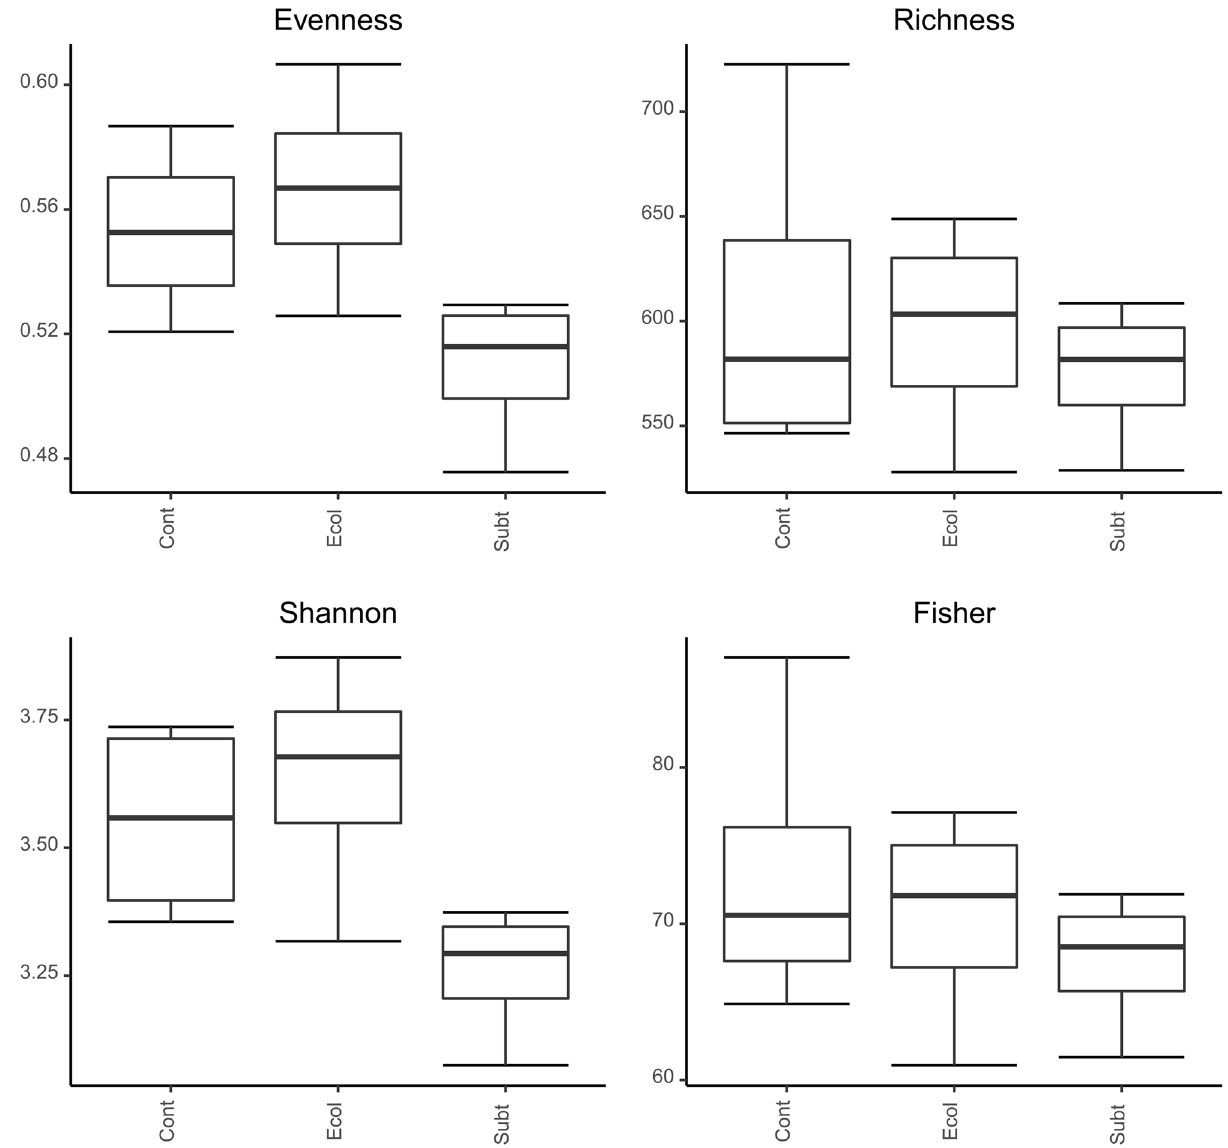
Figure 1. Boxplots of selected diversity indices. Results of GLM-ANOVA analyses: Evenness: F 2,9 = 4.3, P = 0.049; Richness: F 2,9 = 0.32, P = 0.734; Shannon: F 2,9 = 4.38, P = 0.047; Fisher: F 2,9 = 0.59, P = 0.573. Cont: Control; Ecol: E. coli DH5α; Subt: P. rubra